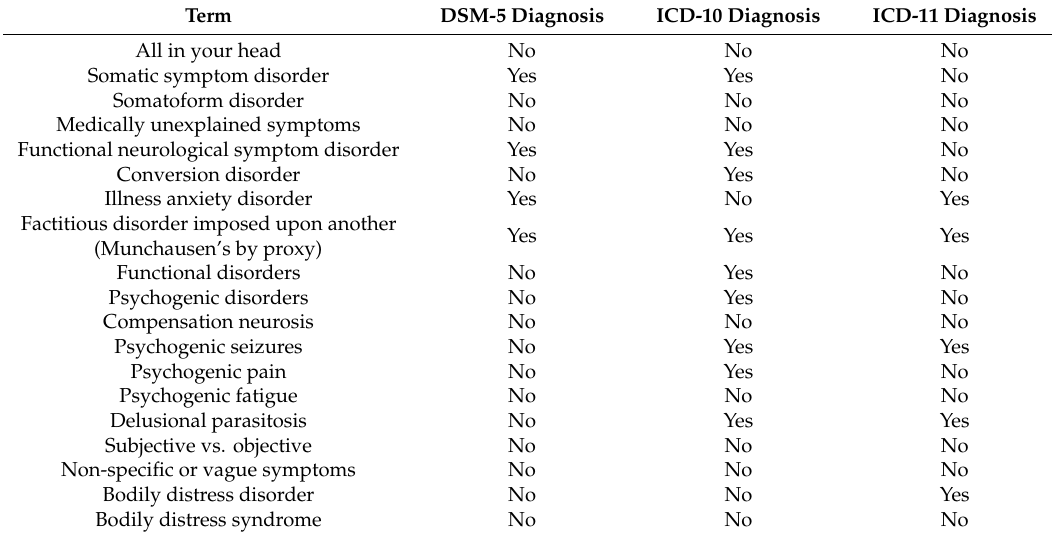
Table 1. Psychiatric diagnostic terms with misuse and abuse